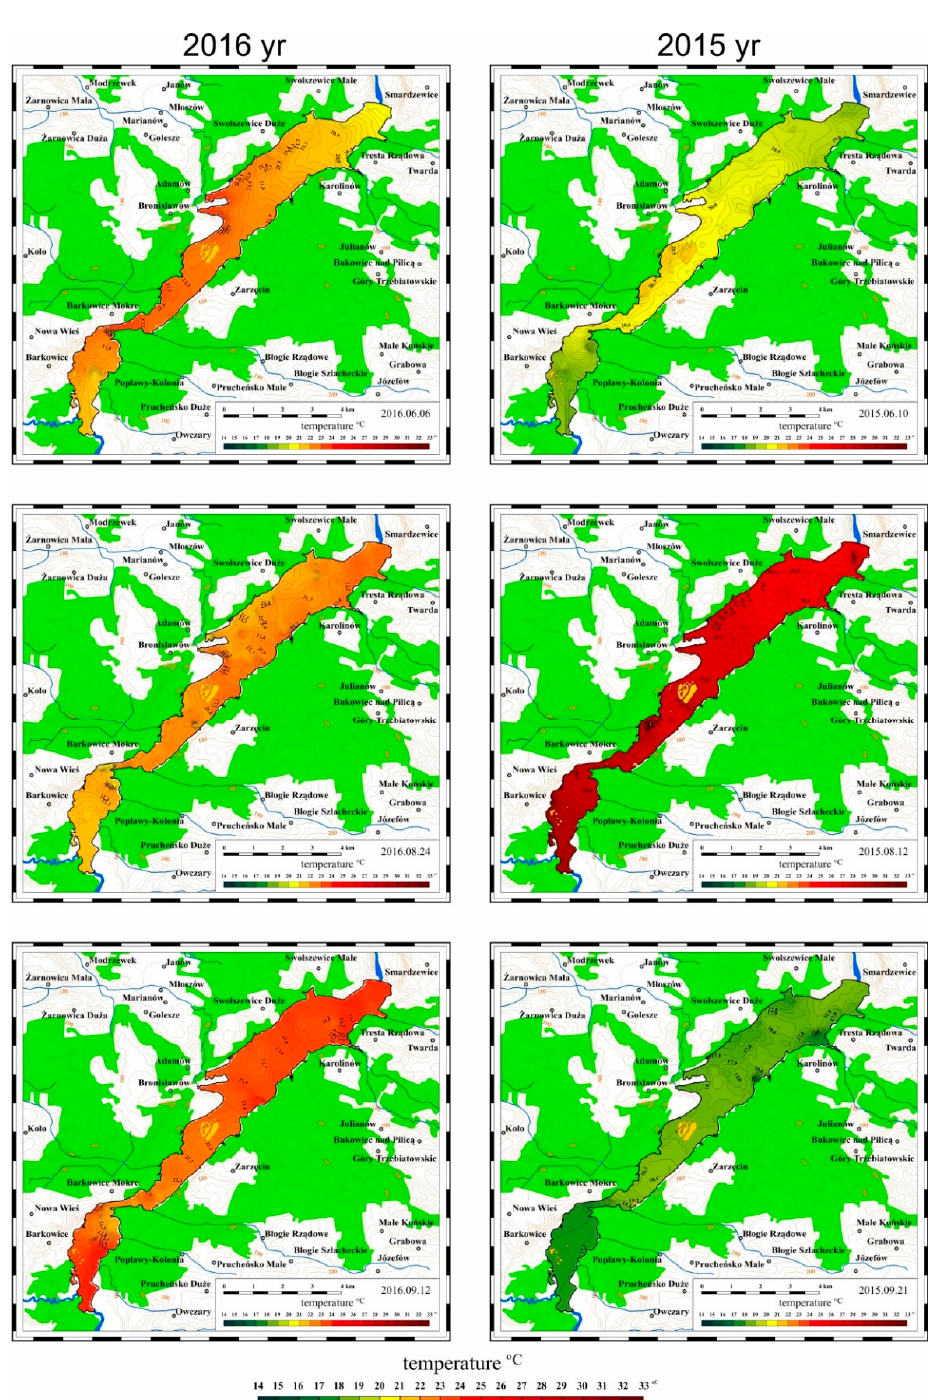
Figure 8. Spatial distribution of water temperature in the Sulejow Reservoir, between June and September 2015 and 2016 (yr: year).